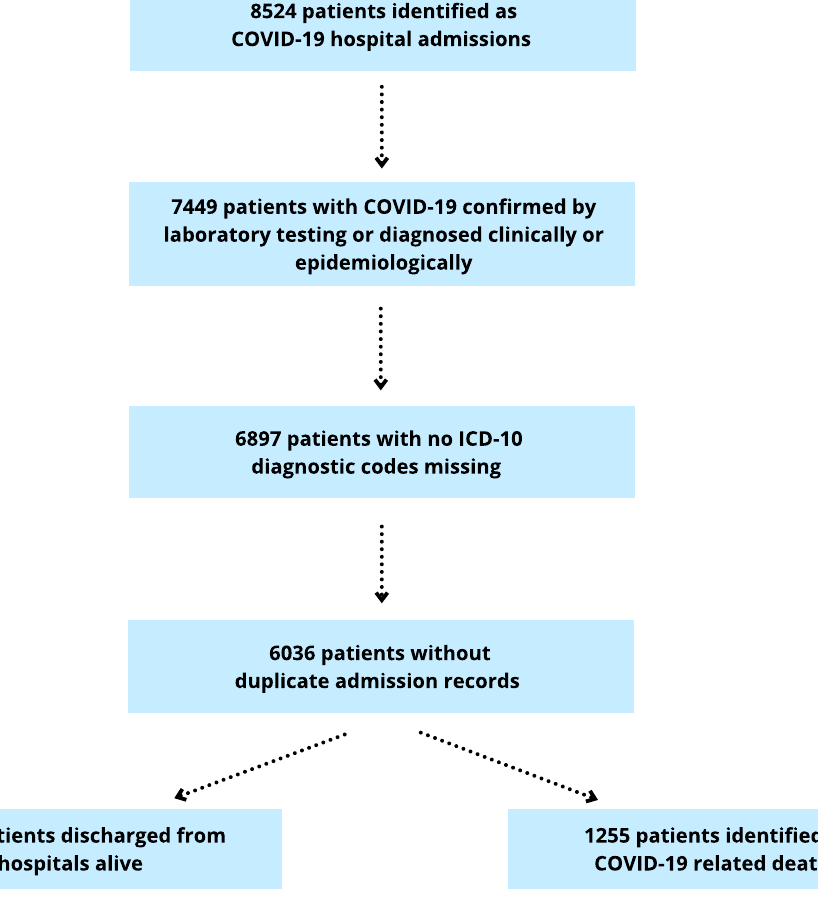
Figure 1. Flow diagram indicating the selection of study